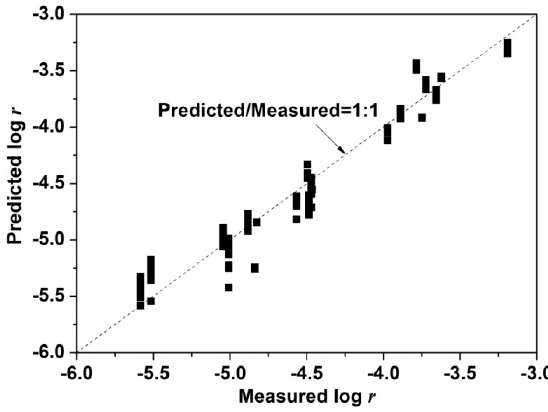
Figure 4. Predicted and measured log(cid:1870) for <10% Cu extraction at 750 mV, 35–75 °C, pH 1.0 (with and without iron addition), 1.5 and 2.0 without iron